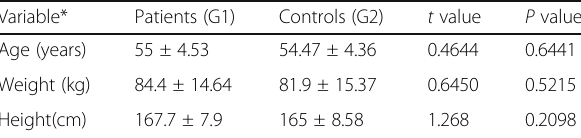
Table 1 Age, weight, and height of patients (G1) and controls (G2)